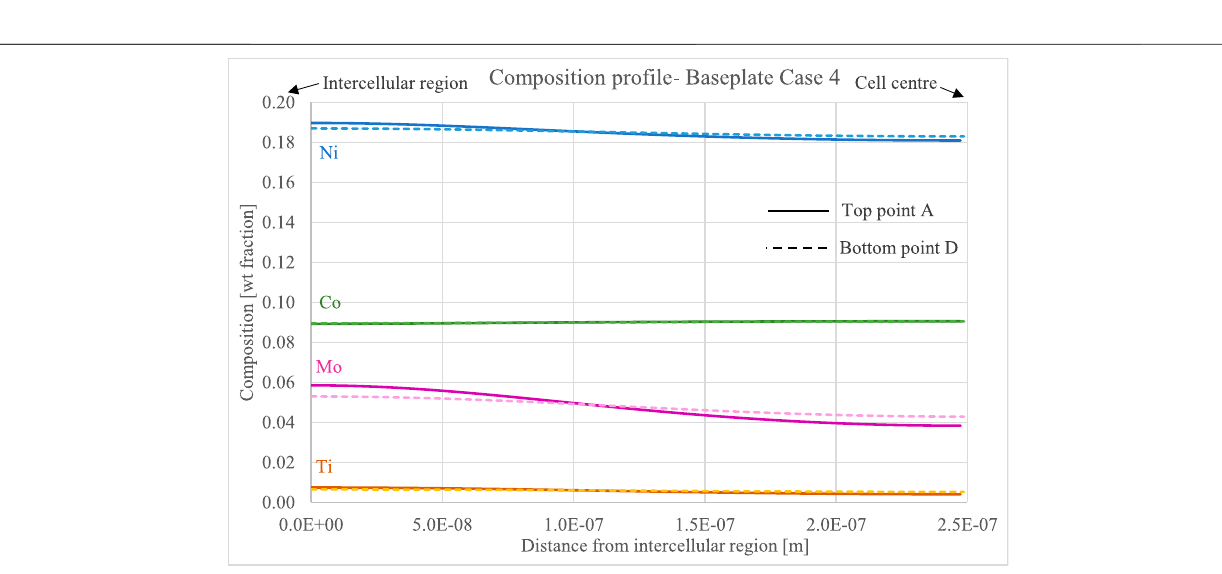
FIGURE 13 | Calculated composition pro fi le for Case 4 for points A and D. Dendrite/cell center at the right side and interdendritic/intercellular region to the